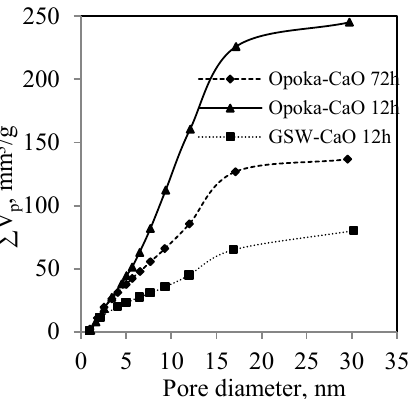
Table 4. Values of the measured and calculated specific surface area of the synthesis samples obtained at 200 °C in un- stirred suspensions with CaO/SiO 2 = 1.0.